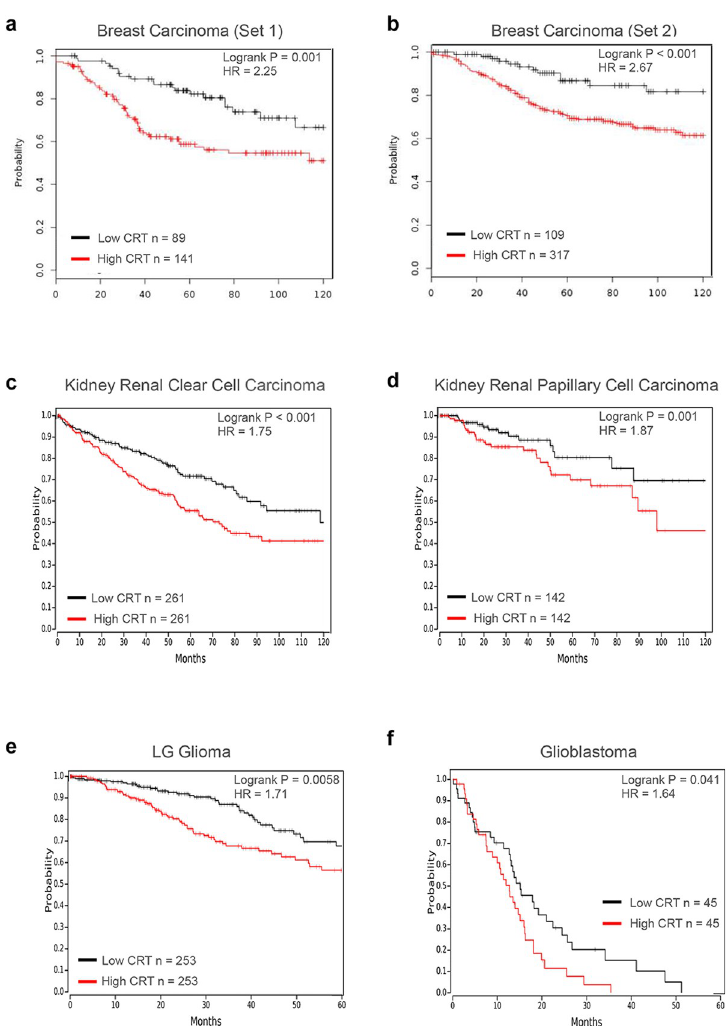
Fig 7. CRT expression inversely correlates with patients survival diagnosed with multiple types of solid cancers. Kaplan-Meier survival analysis is shown for patients diagnosed with breast- (A–B), kidney- (C–D), and brain- (E–F) derived malignancies. Patients were stratified into high and low groups based on median CRT expression (C, D, E) or using an optimal cut-off approach (A, B, F), and overall survival is plotted. Clinical data sets were downloaded from either Gene expression Omnibus (A: GSE 21653, B: EM5BC) or TCGA (–-F) using online database tools [33, 34]. p - Values were determined using log-rank test; HR was determined using a univariant Cox regression model; values are shown for the relationship of outcomes to dichotomous expression of CRT. CRT, calreticulin; HR, hazard ratio; TCGA, The cancer genome atlas.